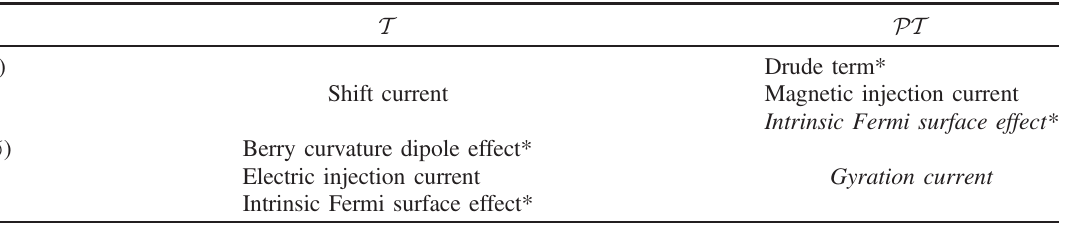
TABLE I. Classification of photocurrent responses in terms of T and PT symmetries and of linearly polarized ( ↕ ) and circularly polarized ( ↺ ) light. Note that the entries with the superscript “ * ” are allowed in metals. The italic font is for classes clarified by this